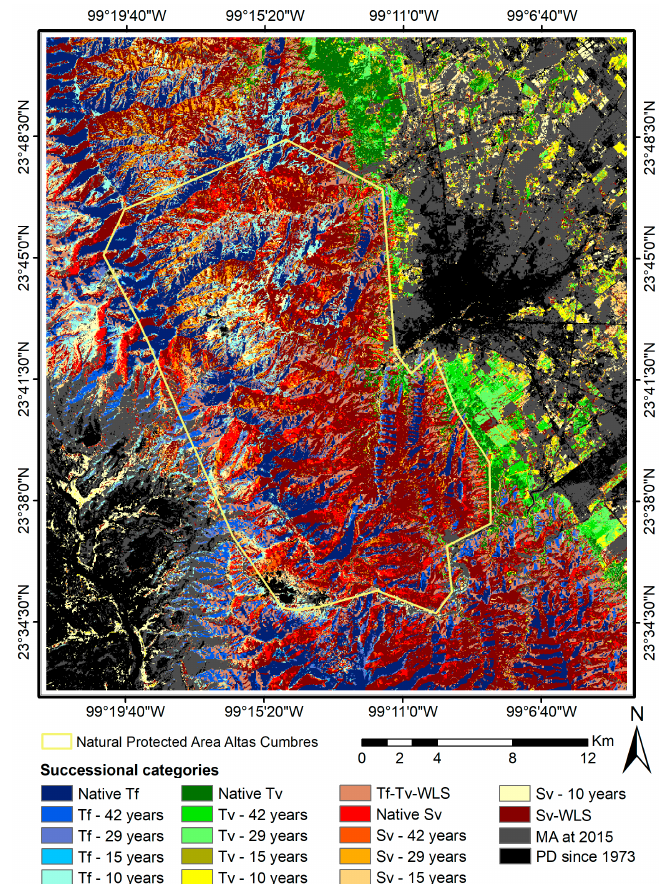
Figure A5. Land use-cover in 2015, Natural Protected Area Altas Cumbres and adjacent area. Victoria, Tamaulipas, Mexico.